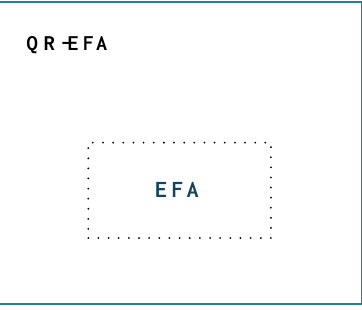
Figure 2. Overall collaboration between QR-EFA and EFA.